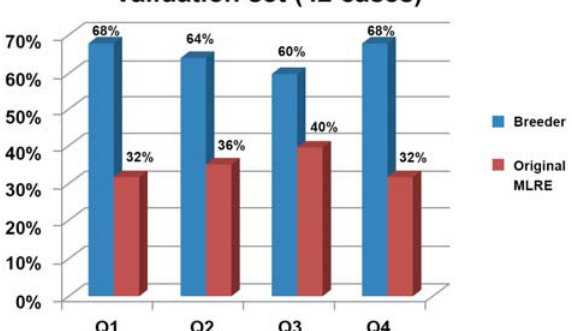
Figure 5- The comparison of prediction error in quadrant 3